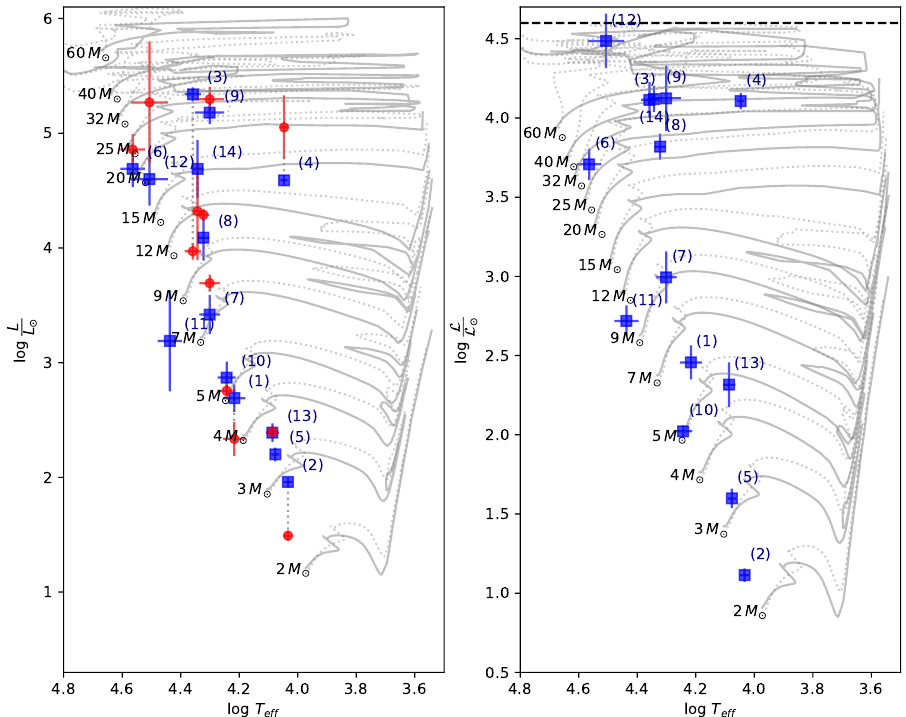
Figure 15. Left : The HR diagram of the stars studied in Aidelman et al. [192] where the dis- tances have been calculated using the M ( λ 1 , D ) absolute magnitudes (blue squares). The red circles indicate the positions of stars as if they were located at distances given by Gaia EDR3 (Bailer-Jones et al., 2021). Evolutionary tracks with and without rotation ( Ω / Ω c = 0.4 and Ω / Ω c = 0.0 are from Ekström et al. [145]). Right : The spectroscopic HR (sHR) diagram as de- fined by Langer and Kudritzki [210]. The dashed black line at log L / L (cid:12) = 4.6 corresponds to the Eddington luminosity limit for a hydrogen-rich composition. The numbers identify the studied stars and the B[e] class classification is indicated in braces: 1 = Hen 3-847 (msB[e]), 2 = FX Vel (msB[e]), 3 = Hen 3-1398 (sgB[e]), 4 = HD 62,623 (sgB[e]), 5 = HK Ori (HAeB[e]), 6 = CPD-24 2653 (msB[e]), 7 = HD 85,567 (evolved msB[e]), 8 = CPD-59 2854 (LBV), 9 = MWC 877 (LBV), 10 = HD 323,771 (HAeB[e]), 11 = HD 52,721 (msB[e]), 12 = HD 53,367 (msB[e]), 13 = HD 58647 (evolved msB[e]), 14 = LHA 120-S 65 (LBV). Adapted from Aidelman et al.